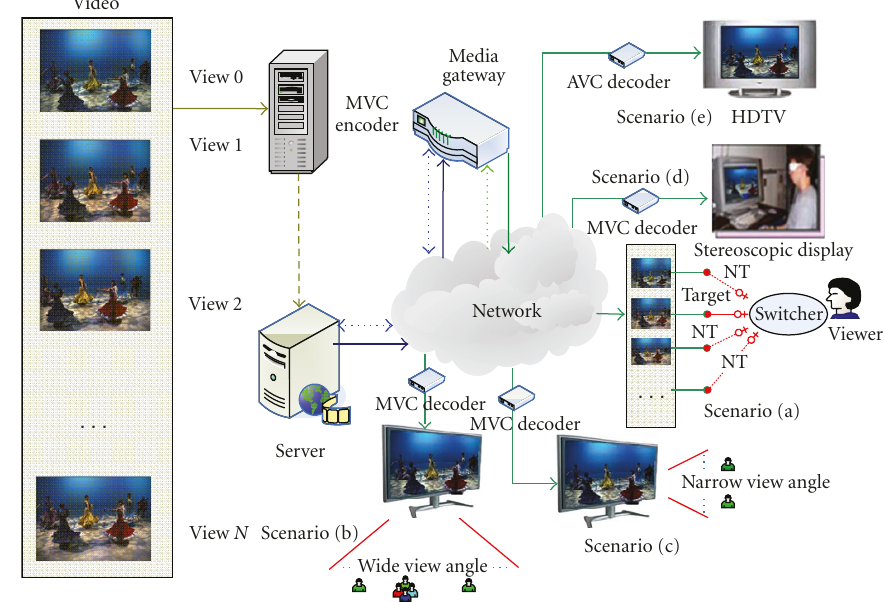
Figure 1: MVC system